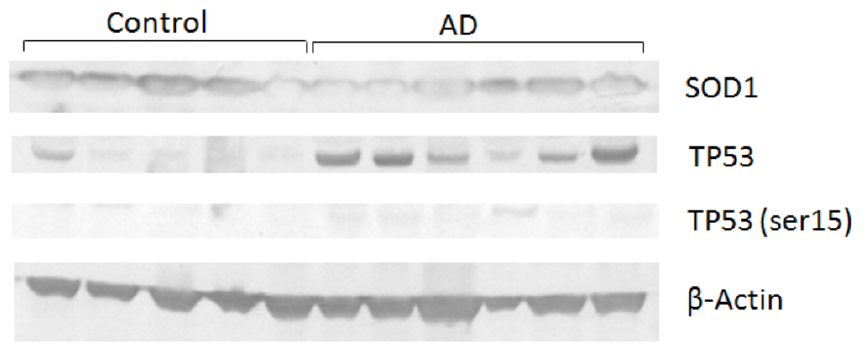
Figure 4. TP53 and SOD1 expression in lymphocytes of AD patients and age-matched control subjects. Protein extraction was performed with the TRIzol reagent, according